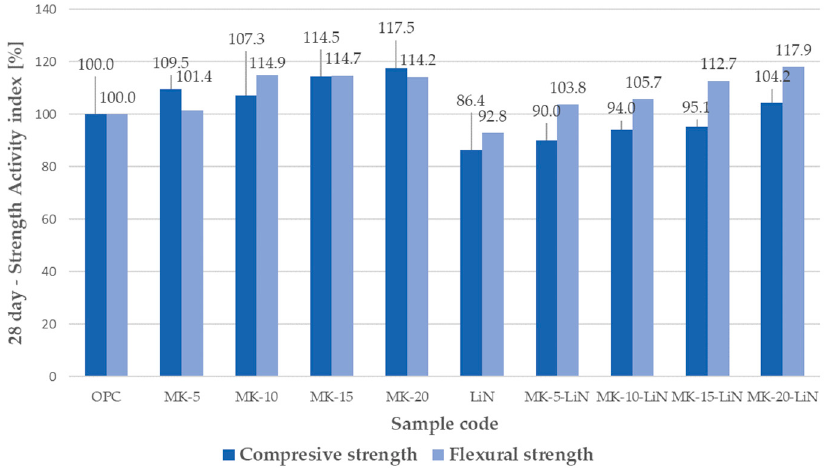
Figure 1. Strength activity index of mortars containing metakaolin and lithium nitrate at 28 days.